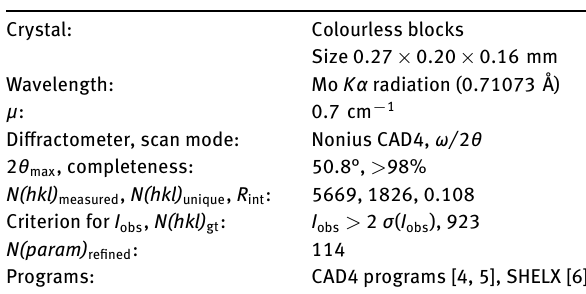
Table 1: Data collection and handling.